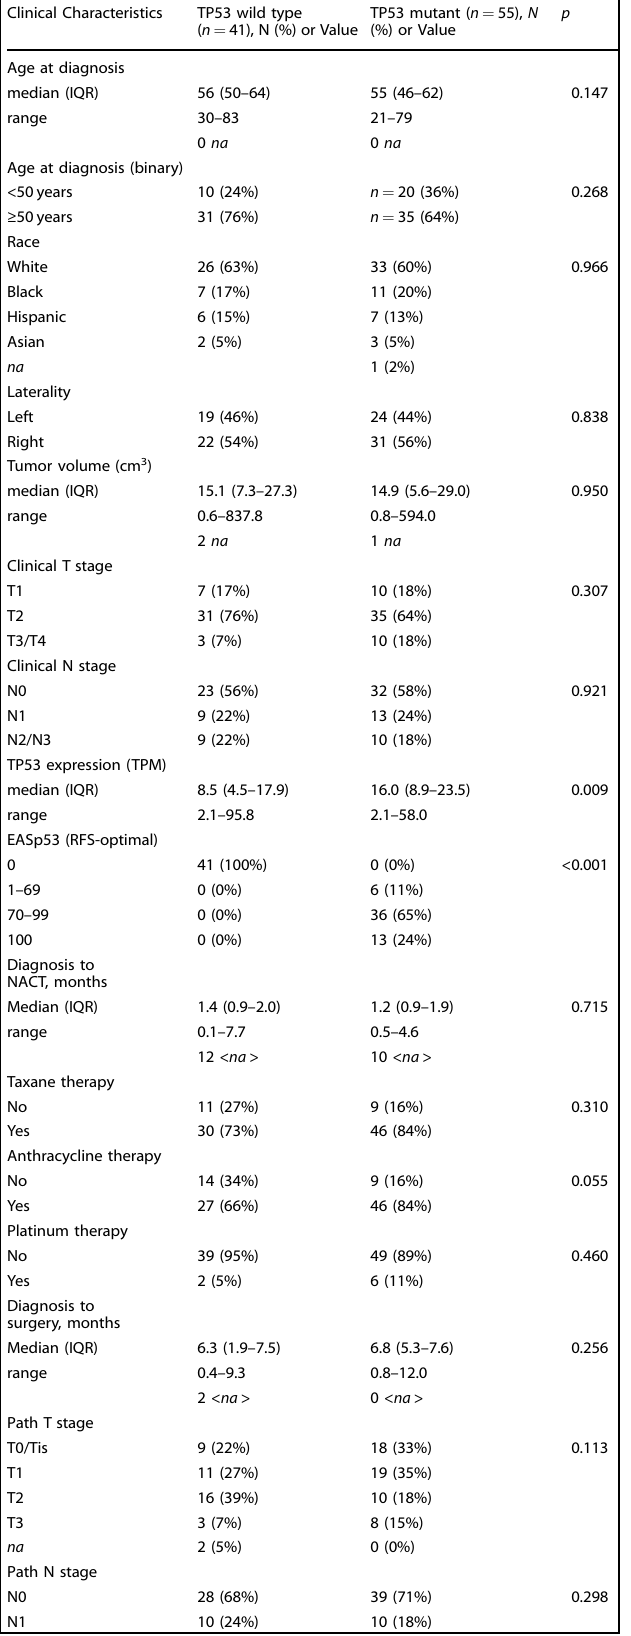
Table 1. Clinicopathological characteristics by p53 mutational status. Clinical